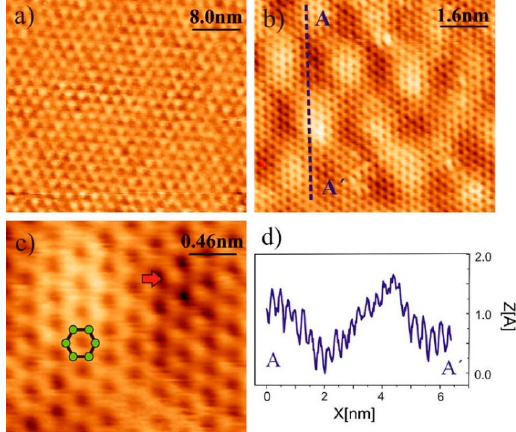
Figure 20. STM images recorded from the same region at the size of ( a ) 40 × 40 nm 2 ; ( b ) 8 × 8 nm 2 ; ( c ) 2 × 2 nm 2 ; honeycomb and three-for-six arrangement showed by hexagonal and red arrow, respectively; and ( d ) a line profile extracted from image ( b ) [55].